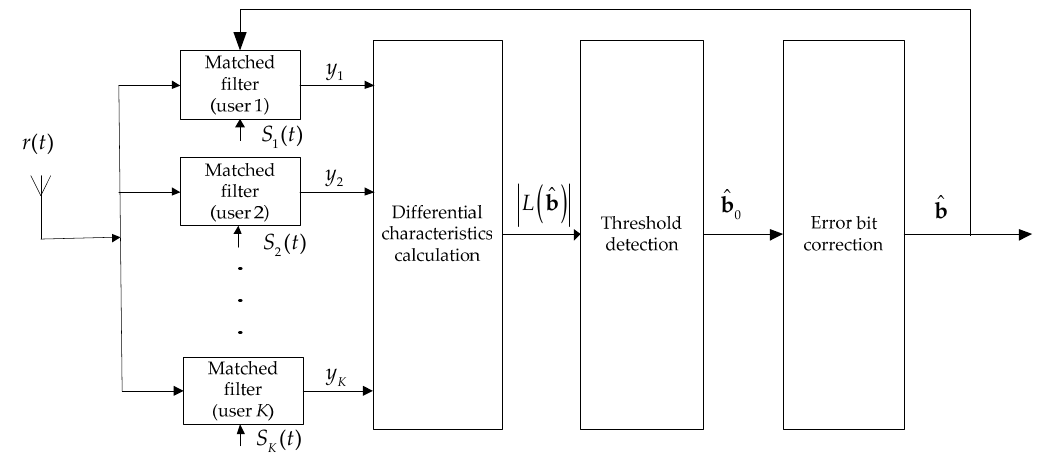
Figure 1. Diagram of the proposed multiuser detection algorithm.